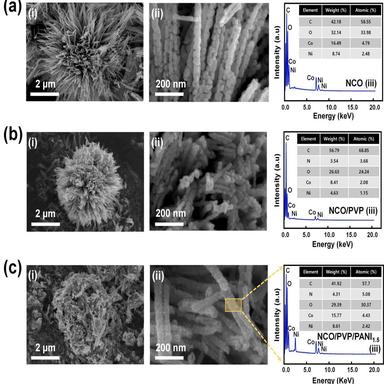
Low magnification and high magnification FESEM images of (a) (i, ii) NCO, (b) (i, ii) NCO/PVP, and (c) (i, ii) NCO/PVP/PANI1.5 composite. (a) (iii) EDX spectrum of NCO, (b) (iii) EDX spectrum of NCO/PVP, and (c) (iii) EDX spectrum of NCO/PVP/PANI1.5 composite.